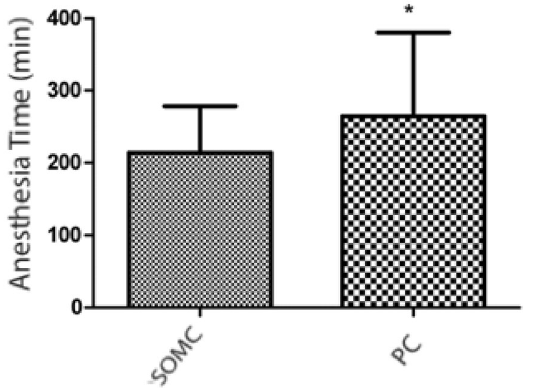
Figure 3. Graphs of anesthesia time (in minutes) of patients who underwent surgical treatment of cerebral aneurysms, excluding middle cerebral artery aneurysms. The supraorbital minicraniotomy (SOMC) and pterional craniotomy (PC) techniques were used. The bars represent the average ± standard deviation for SOMC (n = 34) and PC (n = 32) accesses in patients who underwent aneurysm surgery (*p = 0.0315; unpaired Student’s t test).